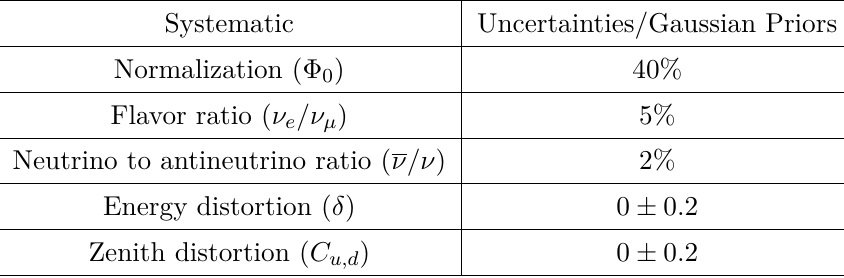
Table 2 . Uncertainties and Gaussian priors in the atmospheric neutrino flux used in our